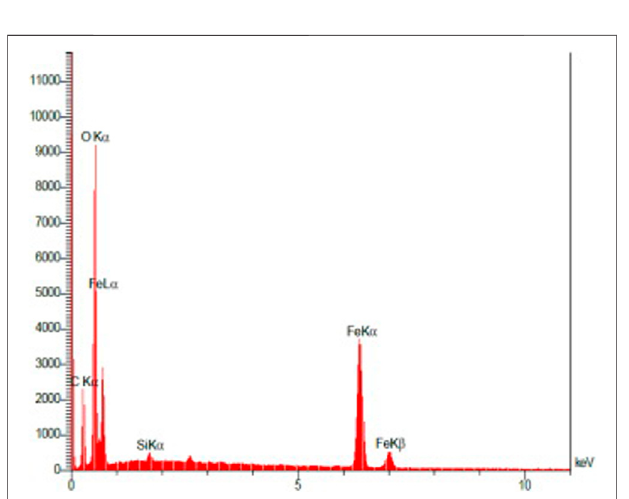
FIGURE 7 | VSM image of synthesized Fe 3 O 4 @SiO 2 @Tannic acid